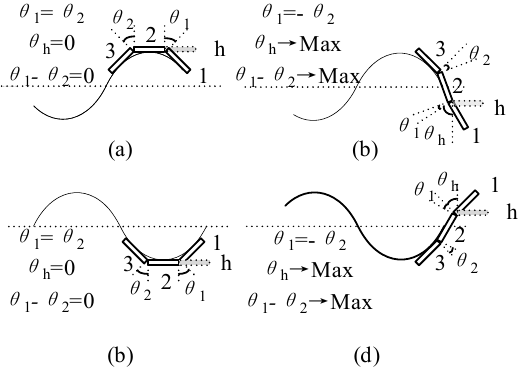
Figure 3. ( a – d ) Four typical cases of head navigation motion. From (3), it can be seen that the main problem of controlling the head direction has been changed to solving the value of the front amplitude coefficient. Add a virtual angle θ v that is out of phase with the first joint the same as that of the first and second joints. Taking this virtual joint as a reference, the crossing time t cross of θ 1 and θ v can be calculated. At the same time, since θ h is equal to θ 1 at this time, the value of the amplitude coefficient A head can be obtained through (4).